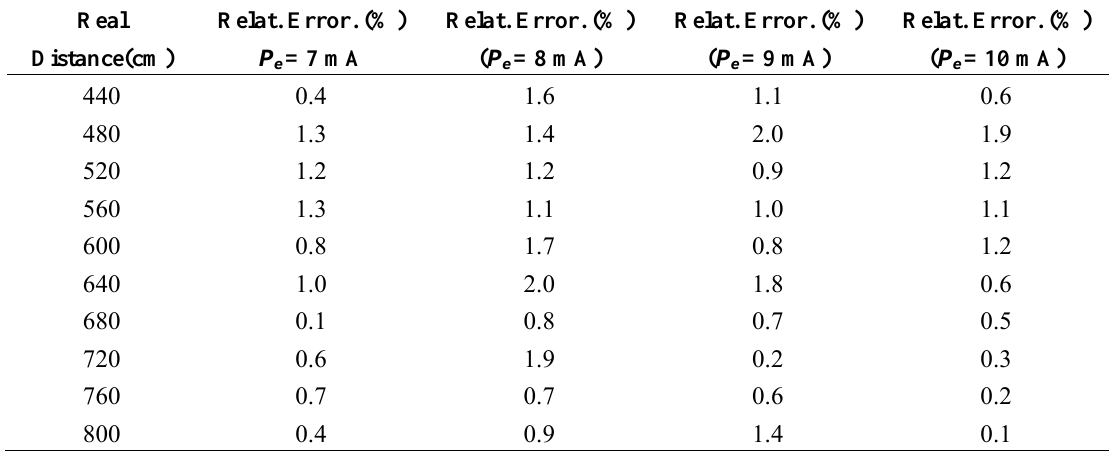
Table 2. Distance Estimation for each polarization current.